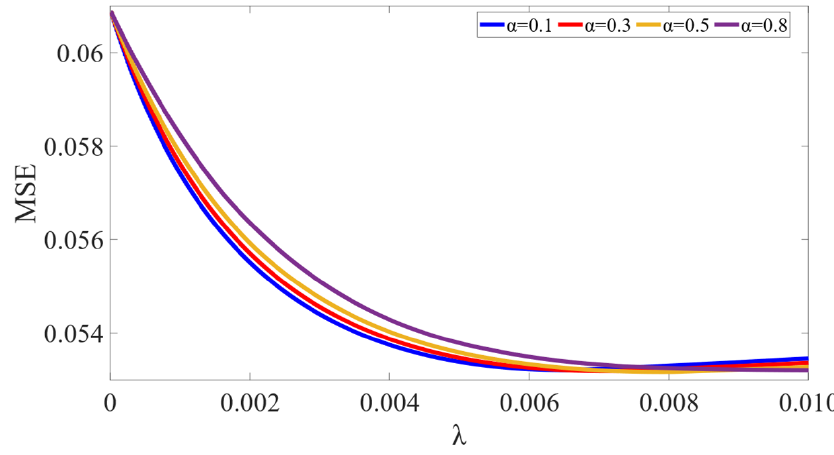
Figure 5. Changes of the validation MSE under the different relaxation variables.